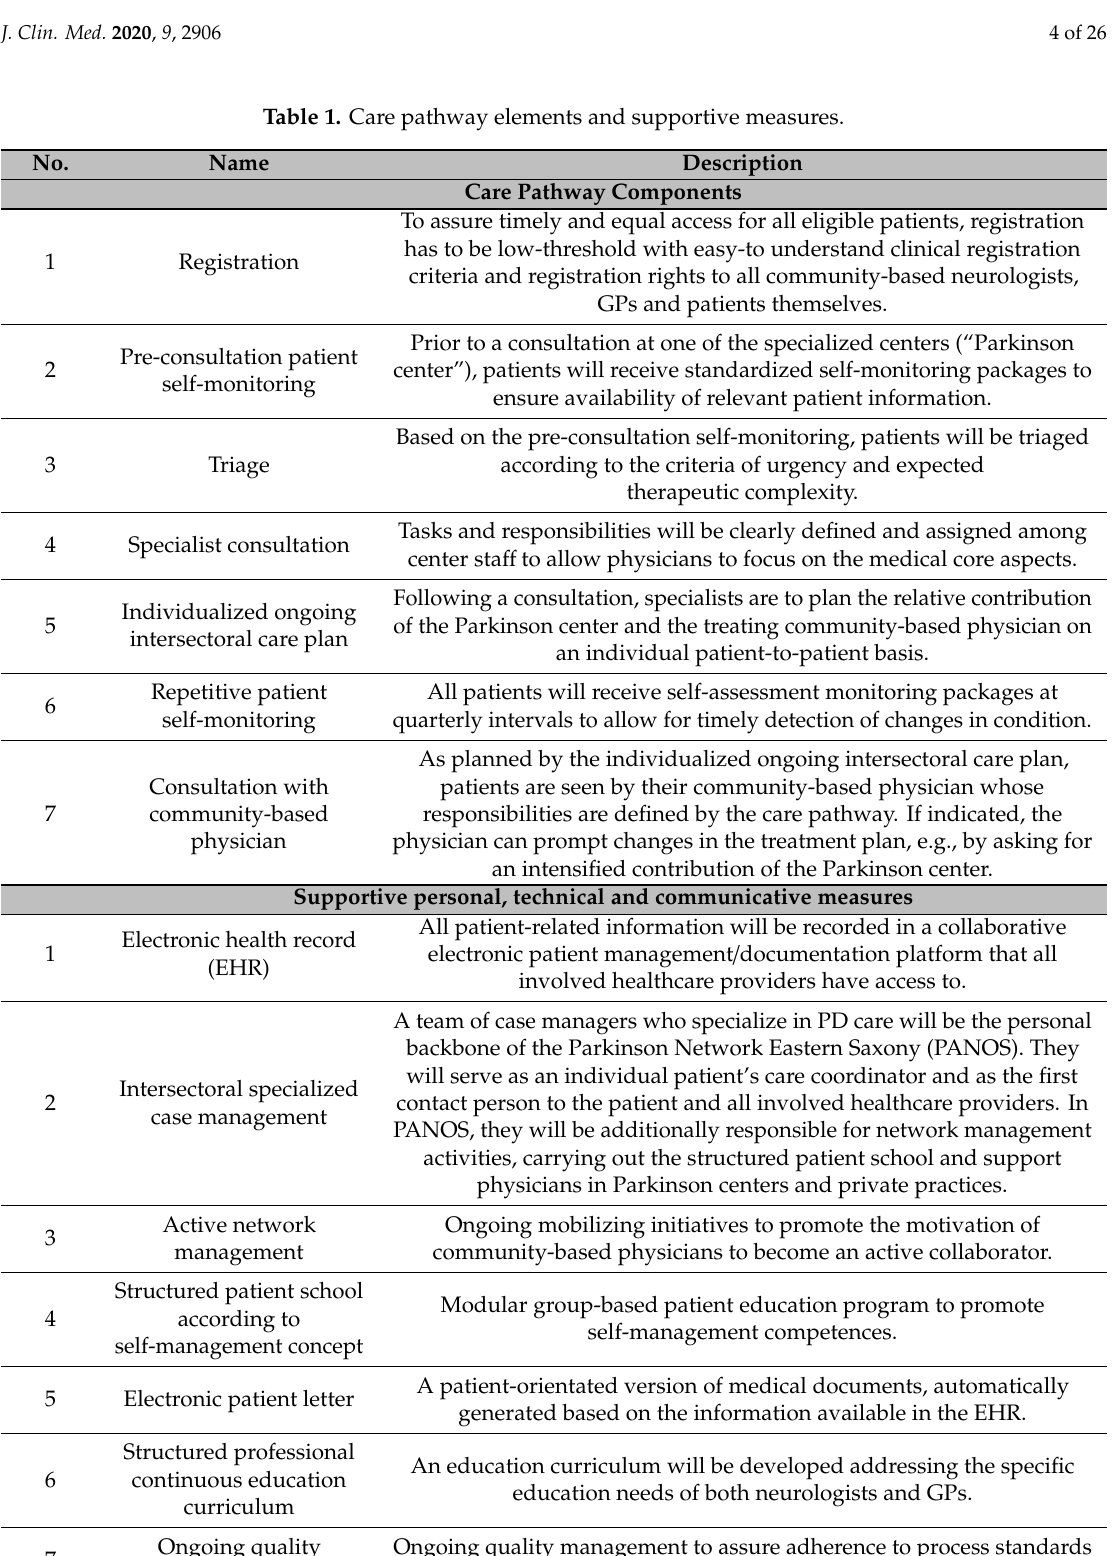
Table 1. Care pathway elements and supportive